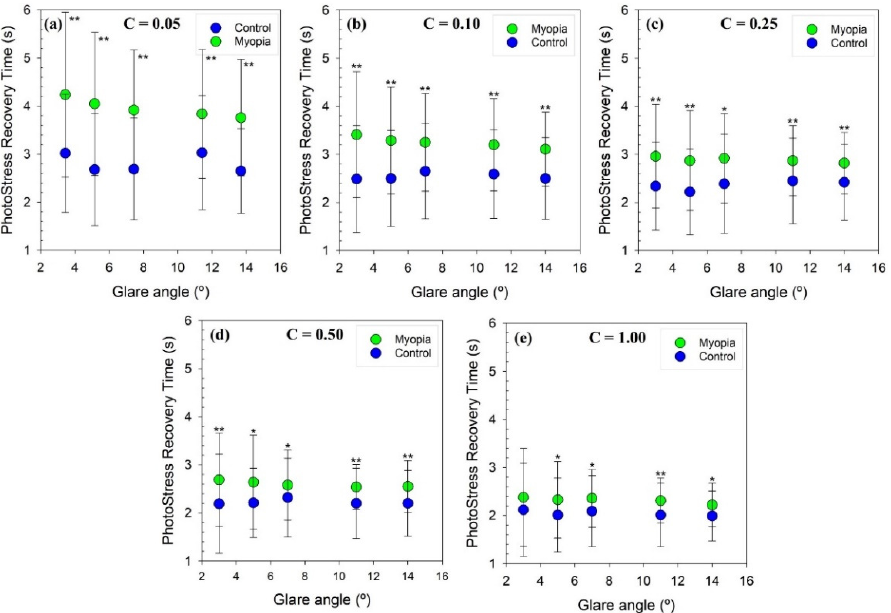
Figure 2. PSRT as a function of the angle of the glare source for each stimulus contrast for myopic (green dots) and control groups (blue dots); ( a ): C = 0.05; ( b ): C = 0.10; ( c ): C = 0.25; ( d ): C = 0.50